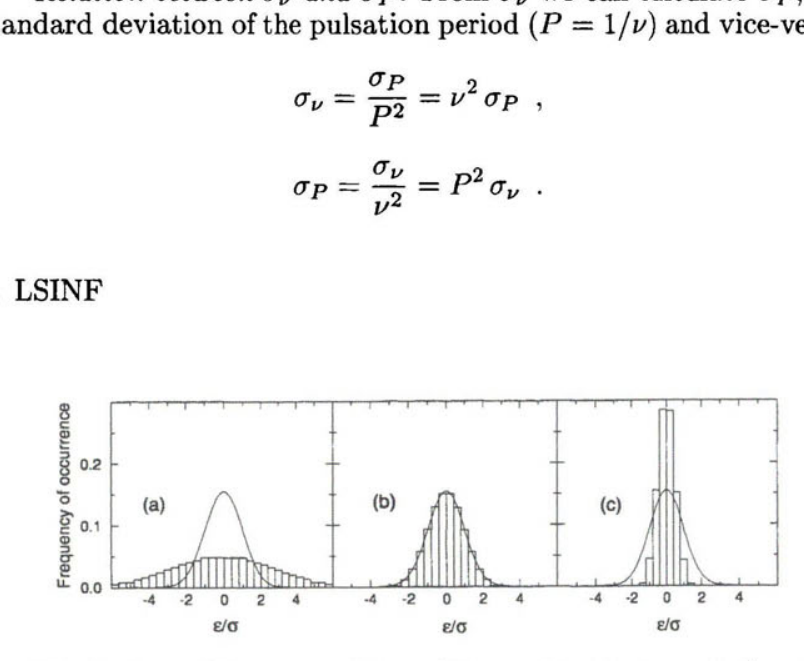
Fig. 3. Error/sigma test. Three different distributions of e/σ values are compared with the espected curve for a Gaussian processes: in (a) the values of σ are underestimated; in (b) the values σ are normal; and in (c) the values of σ are